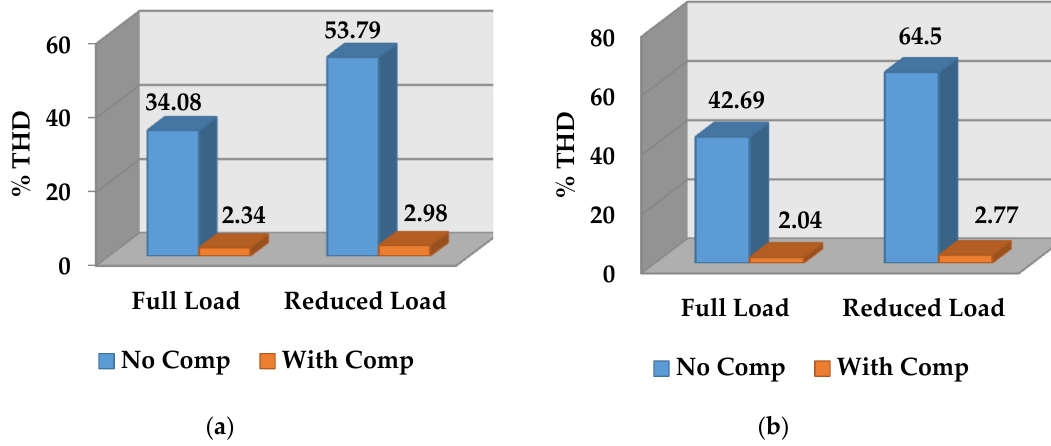
Figure 20. %THD at PCC using MB-HCC: ( a ) ideal grid condition; ( b ) distorted grid condition.